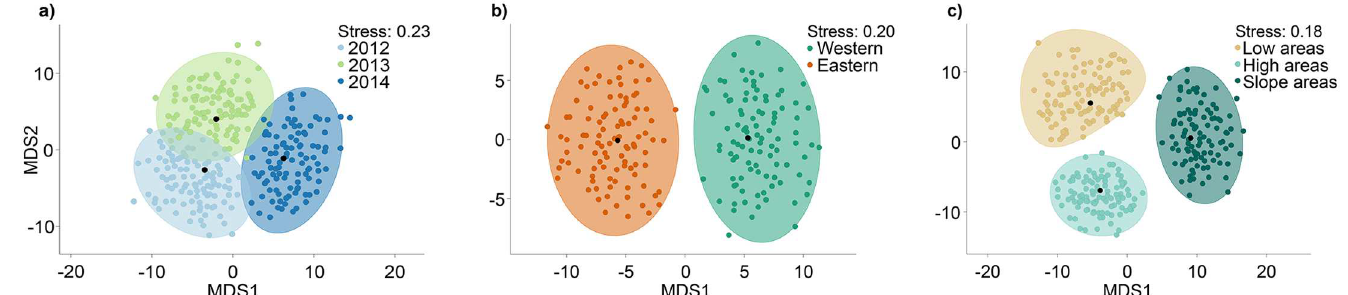
Fig 3. Ordinations of bootstrap averagesof bird assemblages. Two-dimensionalmetric multi-dimensionalscalingordinationsof 100 bootstrap sample averages for each group for each of the main factors: Years (a), Watersheds (b); and Environmental groups (c), showingthe overall mean (black dots) and the empiricalapproximate 95% confidenceregion, based on zero-adjusted Bray-Curtis dissimilarities of square-root transformed abundancesof 98 bird species.